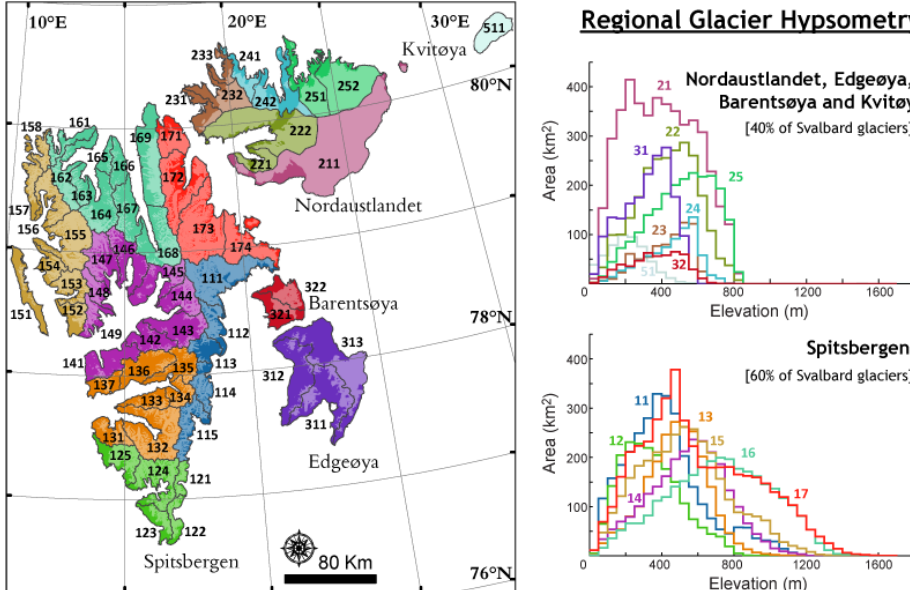
Fig. 2. Regions, primary and secondary drainage basins (i.e. the first three digits of the IDs). The colors depict the primary drainage basins (i.e. the first two digits of the IDs) and correspond to the colors in the glacier hypsometries shown to the right. Glacier hypsometries are extracted from the ASTER